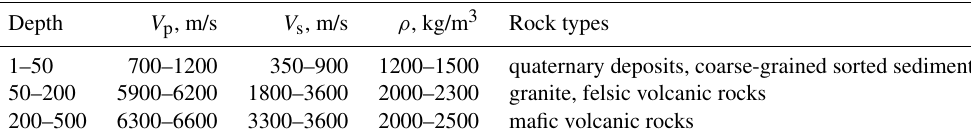
Table 1. Starting model of the medium used for inversion of dispersion curves.